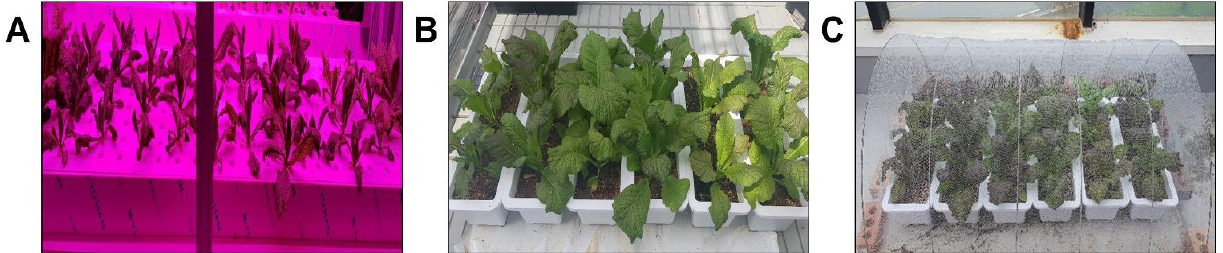
Figure 1. Cultivation features of B. juncea in indoor farm ( A ), greenhouse ( B ), and outdoor field ( C ). The plants were harvested at the sixth week of cultivation. The growth temperature for crop cultivation was maintained at 18–23 ◦ C in indoor farm ( A ), 20–28 ◦ C in greenhouse ( B ), and 15–20 ◦ C in outdoor field.